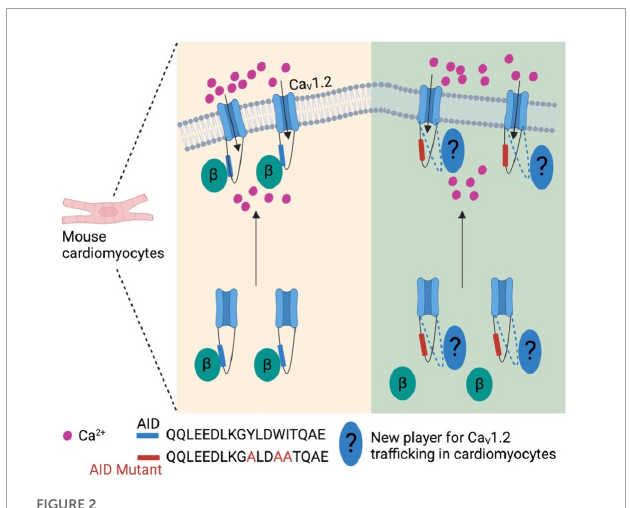
FIGURE2 β subunit-less Ca V 1.2 channels are still trafficked to cell surface in mouse cardiomyocytes. At least in mouse cardiomyocytes β subunit is required for β -adrenergic stimulation on Ca V 1.2 channels, but not trafficking to plasma membrane. This indicates new player(s) is involved in the trafficking of cardiac Ca V 1.2